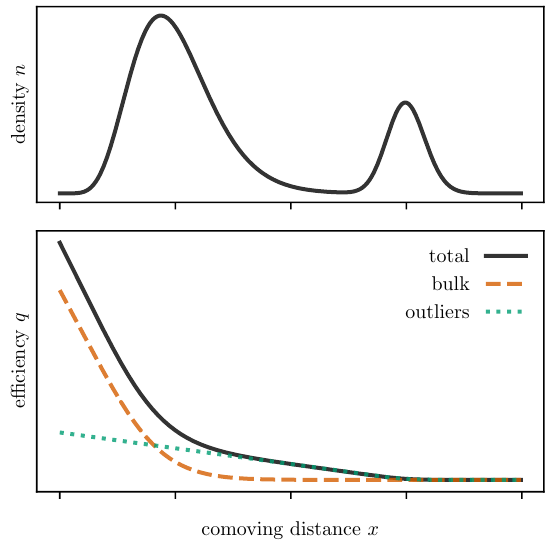
Figure 7. The effect of disjoint outlier populations on the lens- ing efficiency. The total lensing efficiency ( solid ) has two distinct slopes corresponding to the lensing efficiencies of the bulk ( dashed ) and the outlier ( dotted )